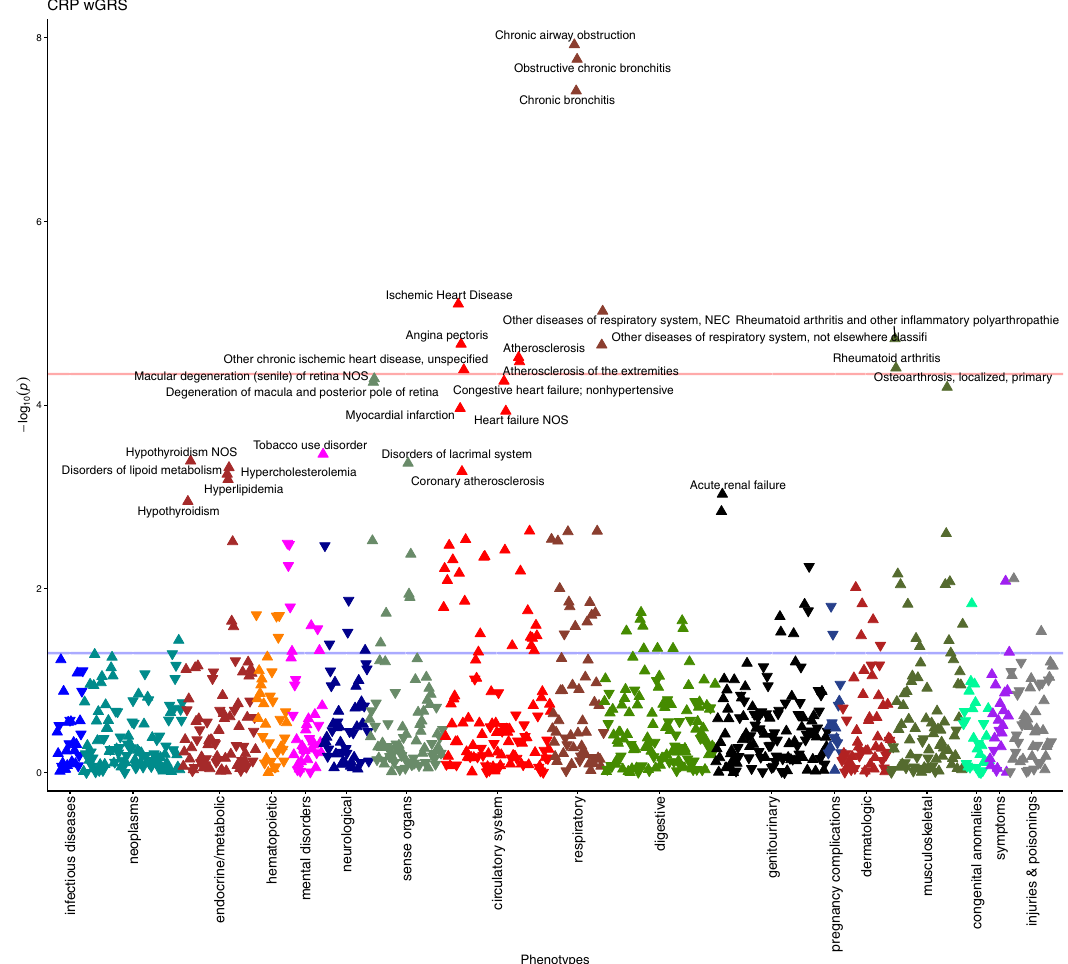
Fig. 5 CRP weighted GRS PheWAS Manhattan plot. The red line indicates the Bonferroni threshold ( p < 4.47 × 10 − 5 ) and the blue line indicates the nominal threshold ( p < 0.05). The triangle pointing up represents positive association and down a negative association. All FDR signi fi cant phenotypes are annotated (FDR q <